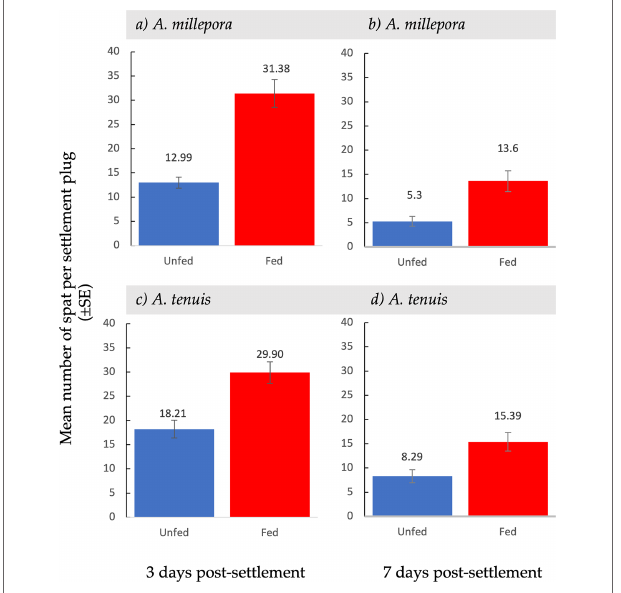
FIGURE 2 | Mean settlement ( ± SE) of unfed and fed Acropora millepora (A, B) and Acropora tenuis larvae (C, D) , after three days (A, C) and after seven days (B, D) after larvae were provided with settlement